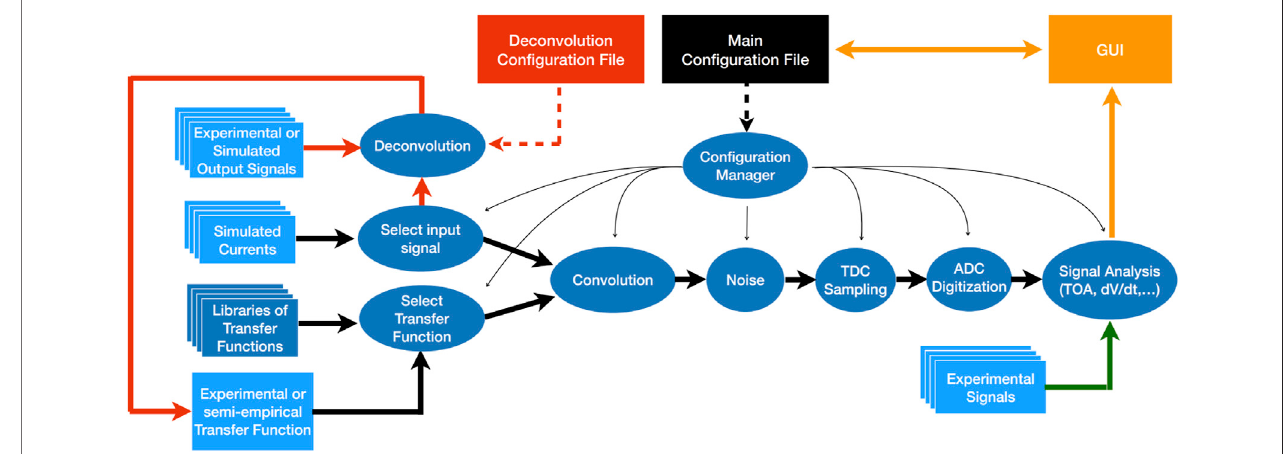
FIGURE 9 | Schematic representation of TFBoost simulations fl ow. The black path is the main simulation in which the convolution and the signal analysis is performed. The green path is followed if TFBoost is used as a pure signal analyzer, while the red path is followed to perform the deconvolution between an input current and an output signal.